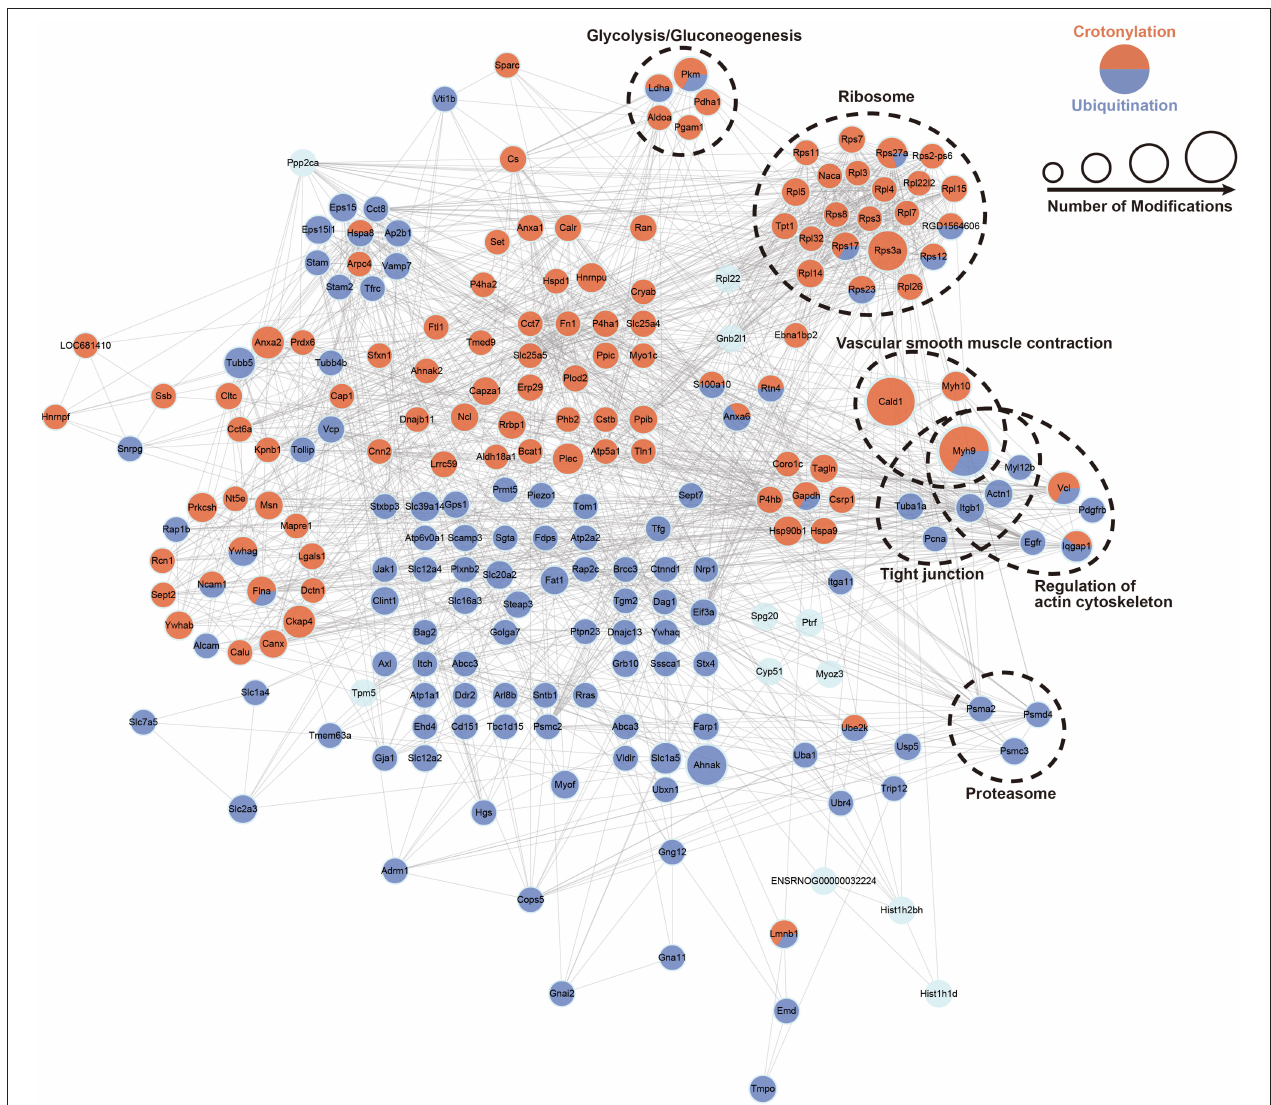
FIGURE 6 | PPI network of a cross talk between crotonylation and ubiquitination was built according to the STRING database. The dotted circles show the functional enrichment of the modified proteins.